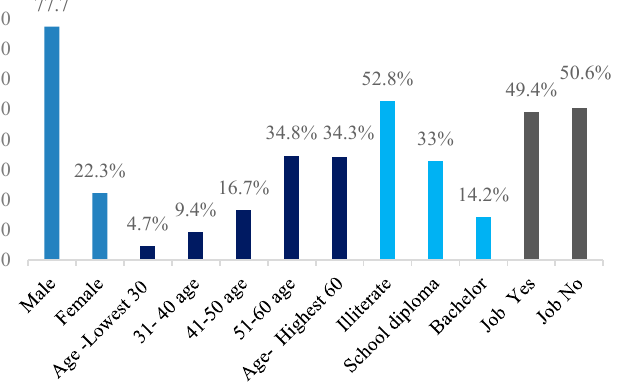
Figure 3. Characteristics of sex, age, education, and employment of rural households (in percent).